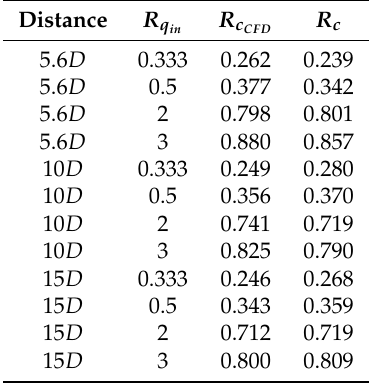
Table 6. Comparison of CFD and experimental results for different R q